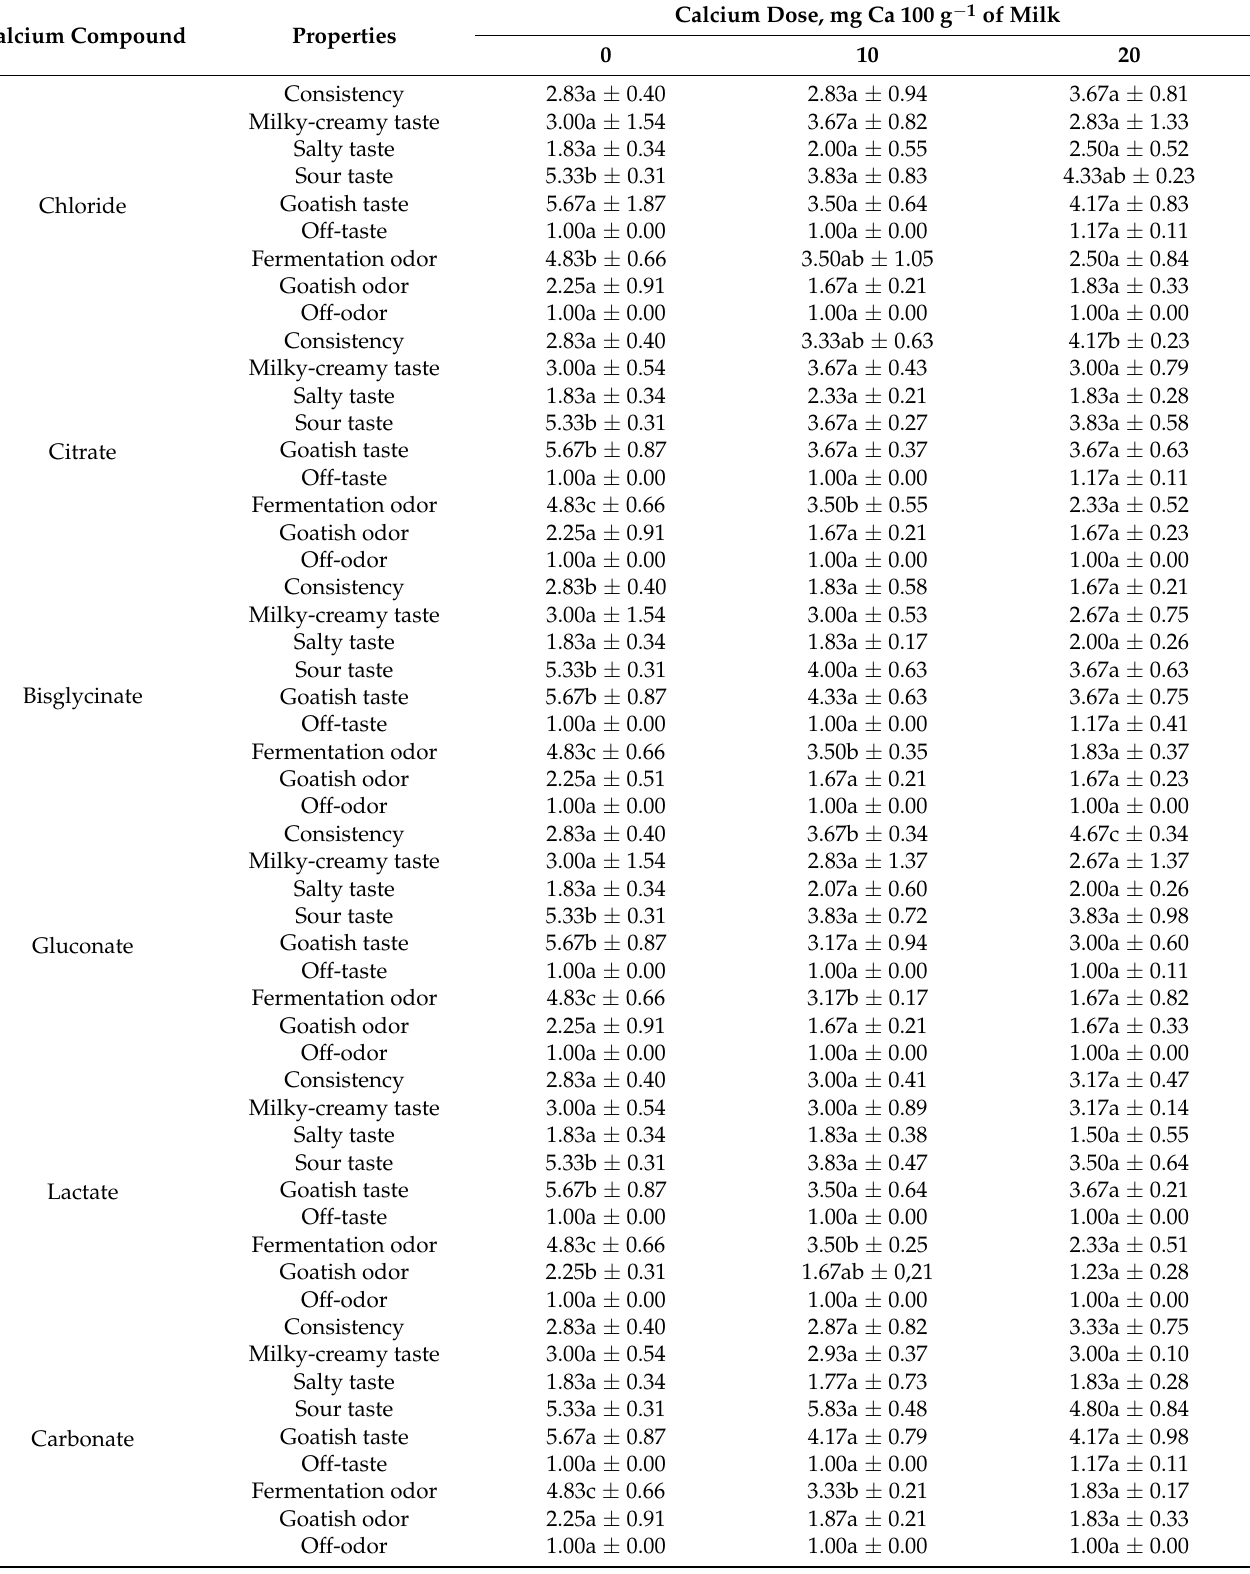
Table 8. Organoleptic evaluation of acid rennet goat’s milk